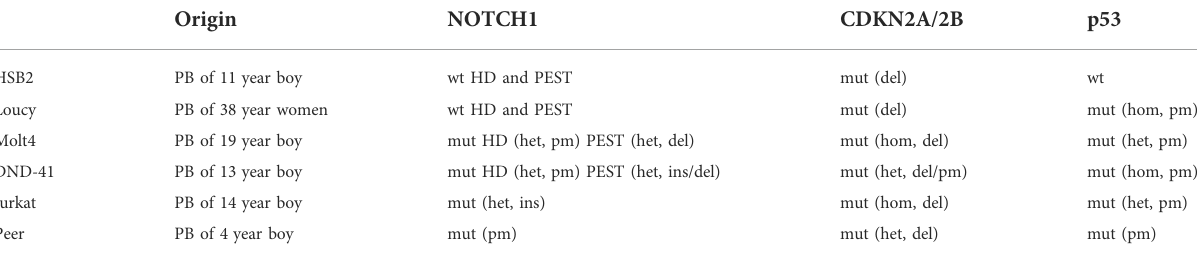
TABLE 2 Human T-ALL cell line